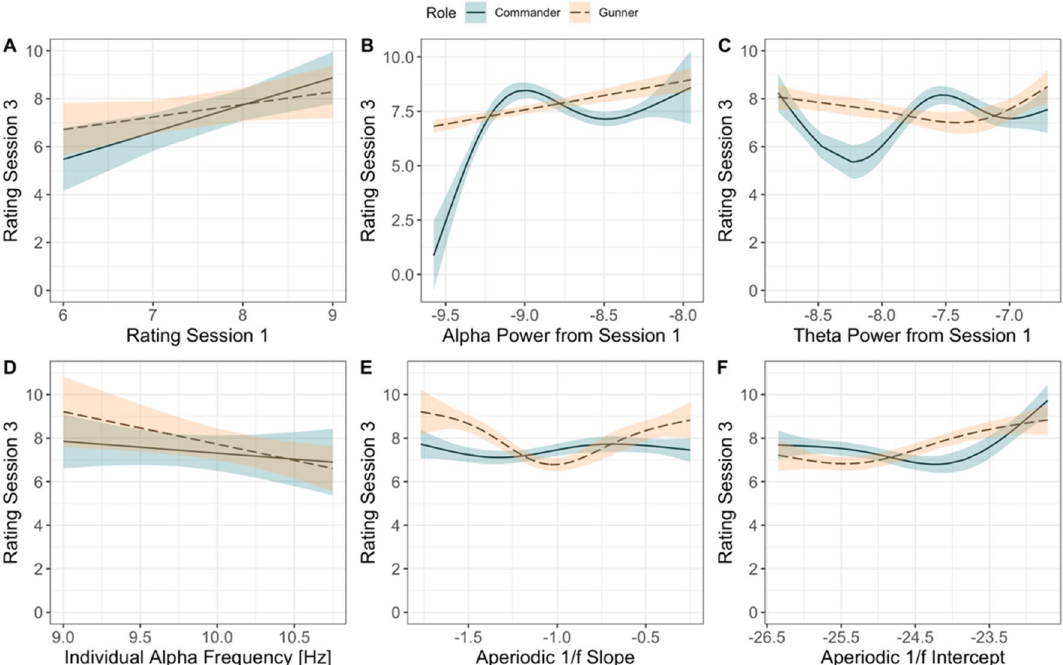
Figure 6. Modelled effects of behavioural, task-related, and resting-state-derived EEG activity on performance ratings from session three for the GBAD task (most difficult training scenario; represented on the y-axis, with higher values indicating better